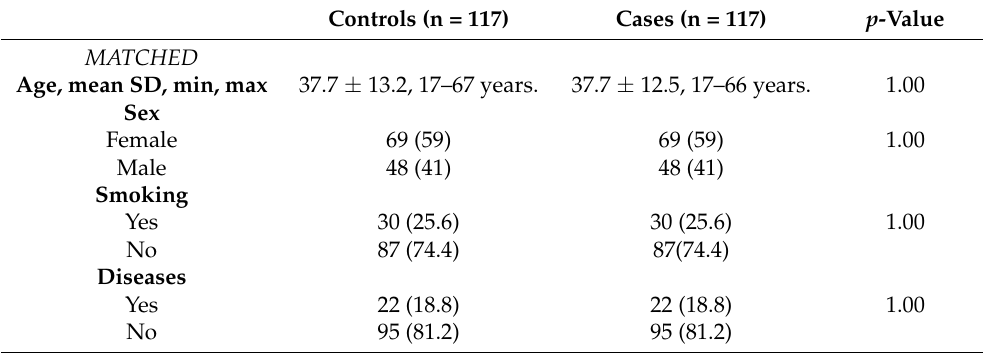
Table 1. Case-control descriptive data and p